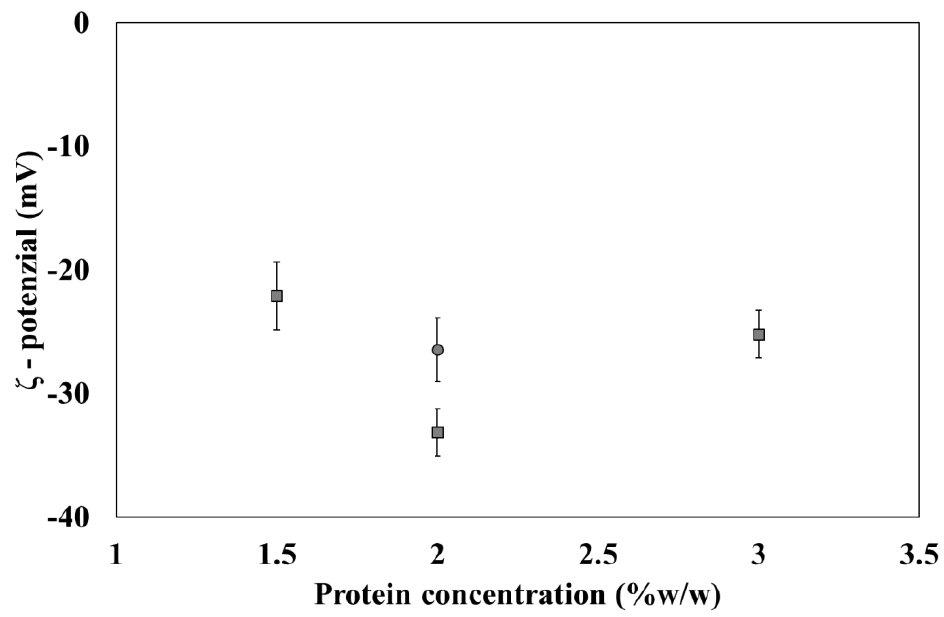
Figure 5. ζ -potential values for investigated samples. The square symbol indicates samples without stabilizing while the circle symbol is for the emulsion with gellan gum (H_2_G).